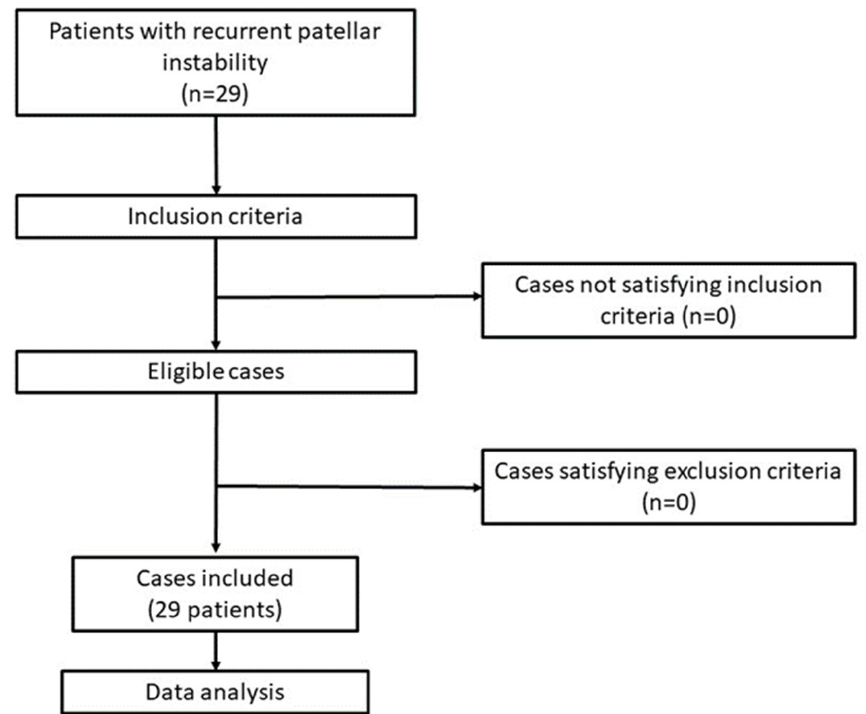
Figure 2. Study’s flow chart.